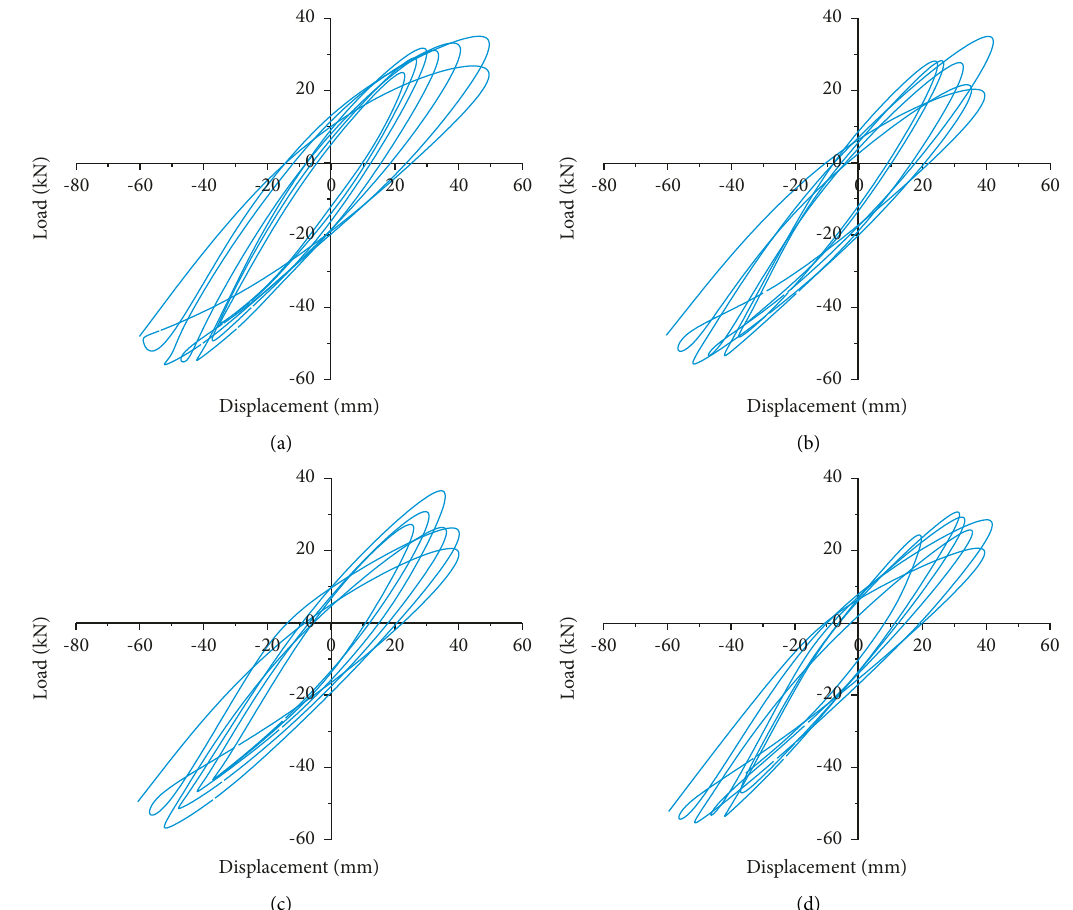
Figure 15: Hysteretic curves of joints with different axial compression ratios. (a) n � 0.2, (b) n � 0.4, (c) n � 0.6, and (d) n � 0.8.